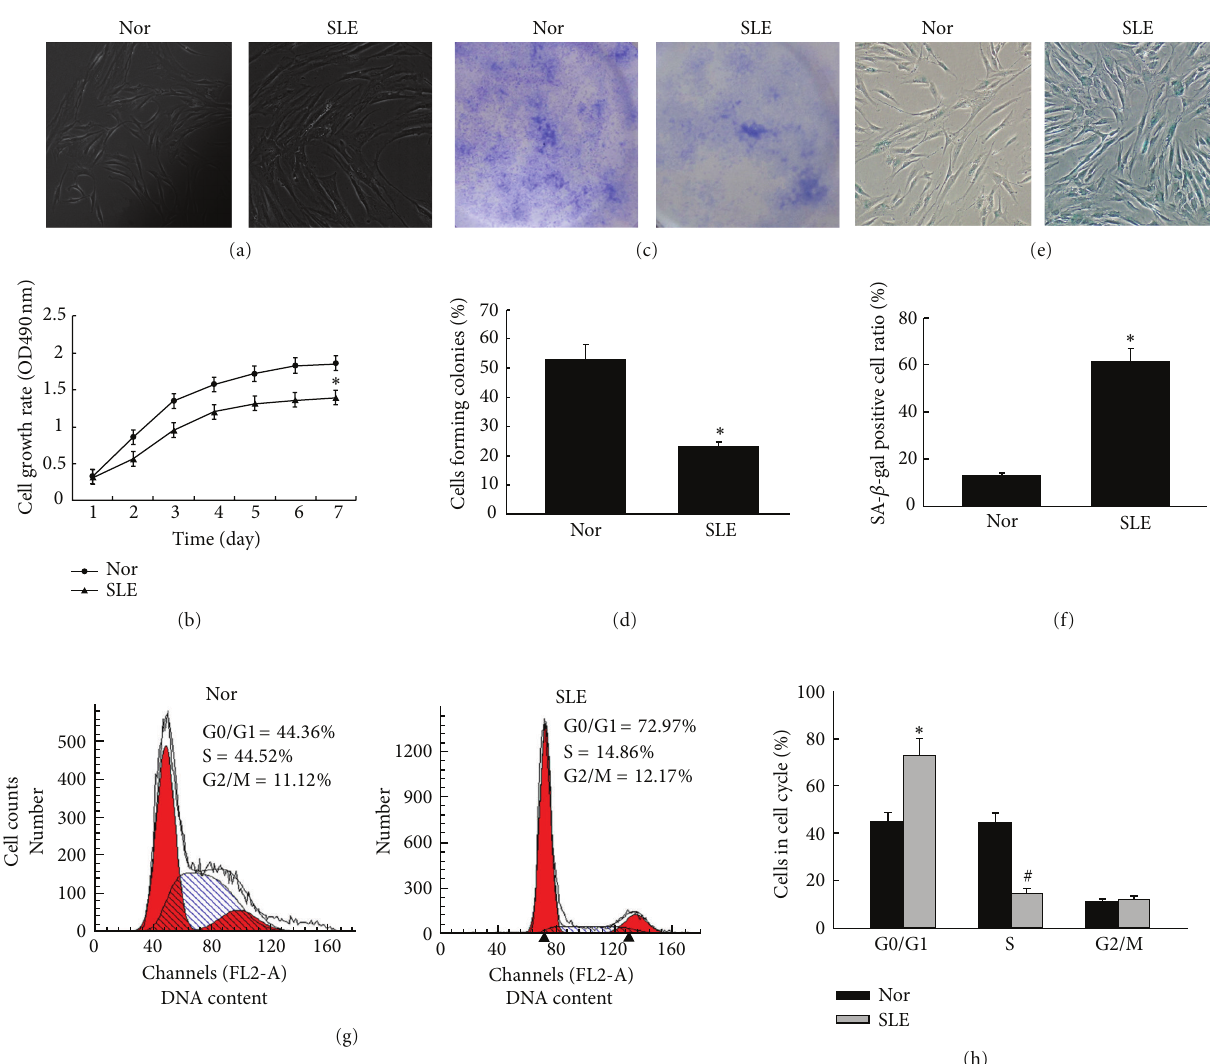
Figure 1: BM-MSCs from SLE patients are aging cells. (a) At p3, the morphology of normal BM-MSCs showed homogeneous spindle-shaped fibroblast-like growth. However, BM-MSCs from SLE patients appeared bigger in size and flattened in appearance. (b) Growth curve of BM- MSCs was tested by cell counting assay. The absorbance was shown as the proliferation rate. BM-MSCs from SLE patients grew more slowly than those from the control group. Each point represents quantities relative to the normal group at Day 1 ( ∗ 𝑃 < 0.05 ). ((c)-(d)) Counted colonies of BM-MSCs from SLE patients and normal control were plated at a density of 25 cells = cm 2 for 15 days in culture, stained with 1% crystal violet. Each bar represents quantities relative to BM-MSCs from Nor group and is mean ± SD of three experiments ( ∗ 𝑃 < 0.05 ). ((e)-(f)) SA- 𝛽 -gal was used to examine BM-MSCs senescence. BM-MSCs from SLE patients and normal control were performed SA- 𝛽 -Gal staining. The number of SA- 𝛽 -gal-positive cells obviously increased in BM-MSCs from SLE patients compared with those of normal control. Each bar represents quantities relative to BM-MSCs from Nor group and is mean ± SD of three experiments ( ∗ 𝑃 < 0.05 ). (g) After cells culture, cells were removed from the culture dish with trypsin/EDTA at p3, fixed, stained for DNA with PI, and analyzed by flow cytometry ( 𝑦 -axis, cell count; 𝑥 -axis, DNA content). (h) Mitotic indices of BM-MSCs from control group and SLE patients. Graphs in (h) represent DNA content indicating the percentages of cells in G0/G1, S, and G2/M phases of the cell cycle. The data are obtained from staining the DNA of ASCs from normal group and SLE patients. A decrease in the percentage of cells in S phases was seen in SLE patients, while an increase in percentage of cells in G0/G1 phase was seen in SLE patients. Each bar represents quantities relative to BM-MSCs from Nor group and is mean ± SD of three experiments ( ∗ 𝑃 < 0.05 ) ( # 𝑃 < 0.05 ). Following the cell cycle progression, these cells showed a greater fraction in quiescent of G0/G1 phase in SLE patients when compared with normal